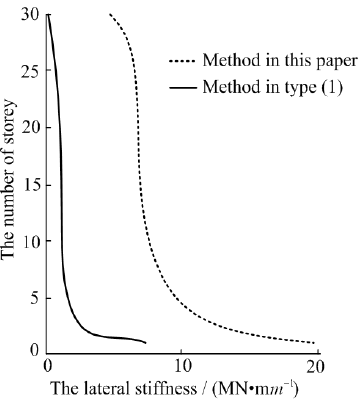
Figure 4: The calculation results of a storey’s lateral stiffness